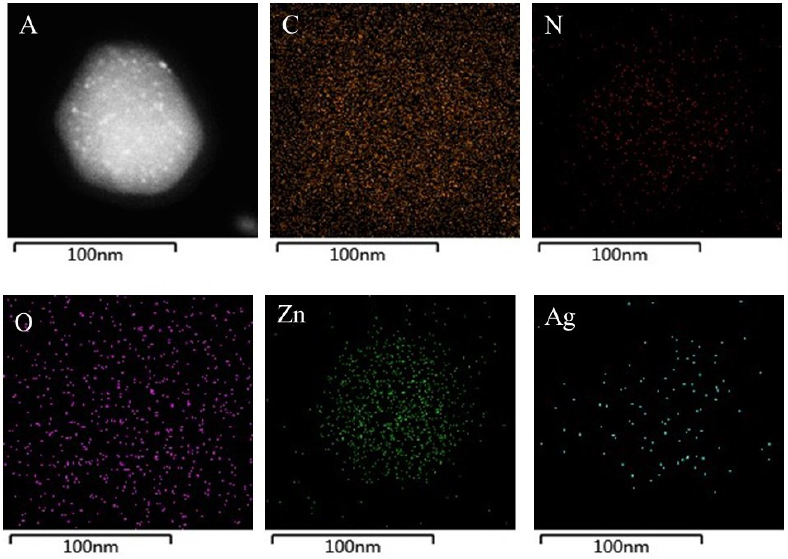
Figure 2. TEM images of MOF-AgNCs ( A ), and the corresponding elemental mappings for the nanocomposite (the element was marked on the images).